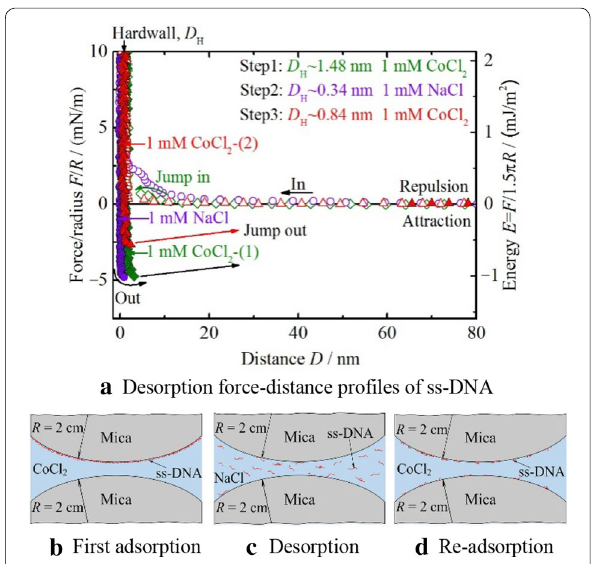
Figure 4 Desorption of ss‑DNA from mica surface with excessive monovalent salts (the ss‑DNA used here is 50